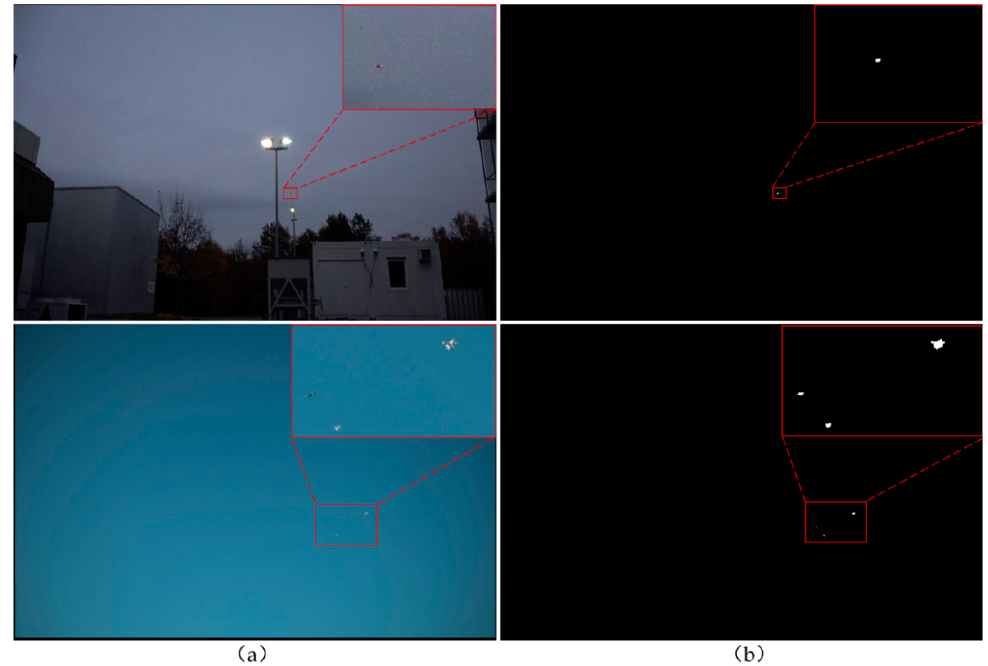
Figure 2. Extraction of potential targets: ( a ) original images; ( b ) results obtained by background difference.